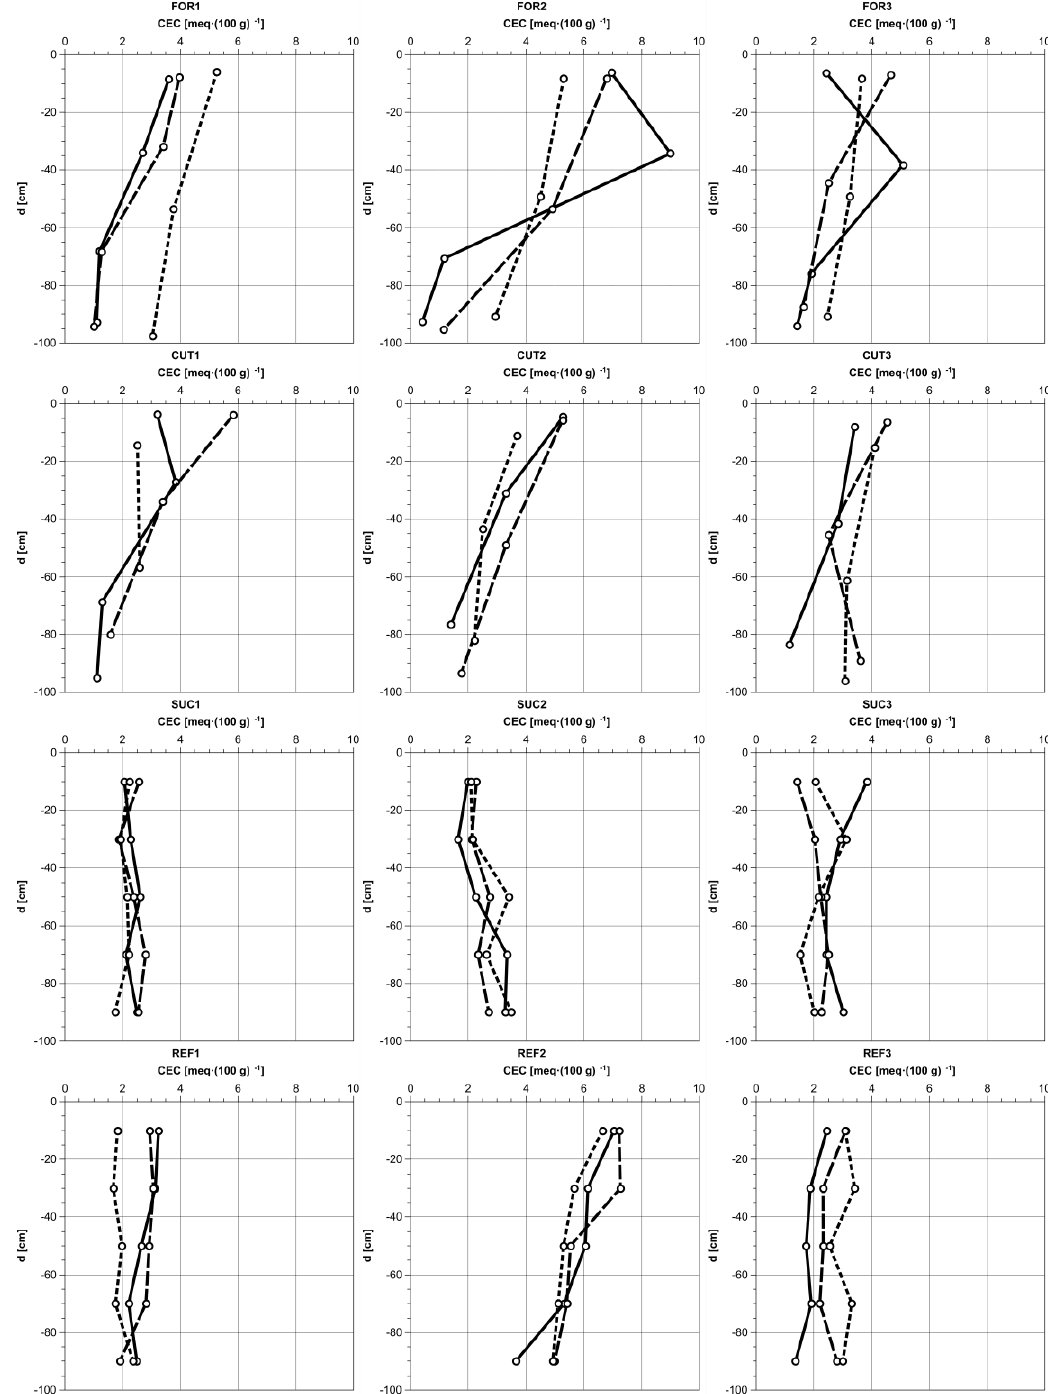
Figure 10. Depth-related CEC content for every catena: (FOR)est, (CUT)-down, (SUC)cession, (REF)forested; solid line: upper slope, dashed line: middle slope, dotted line: lower